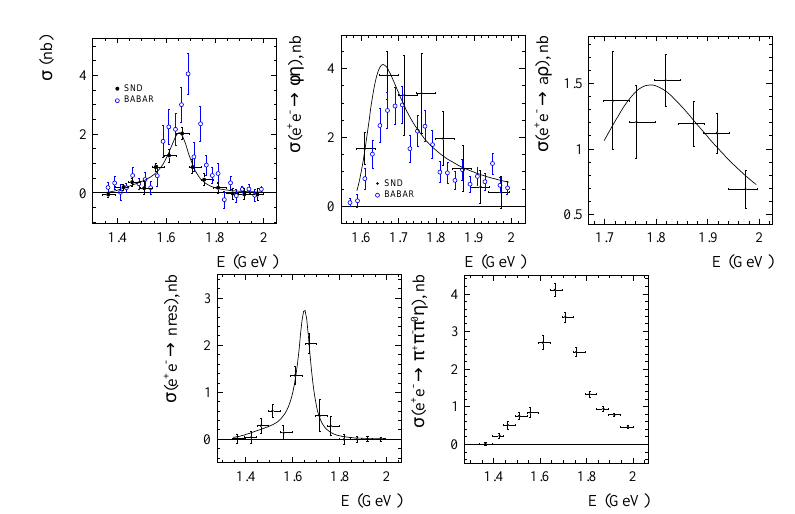
Figure 5. The cross sections measured in this work (filled circles) and in the BABAR experiment (open circles). The curve is the result of the fit described in the text. The errors of the SND data are statistical and systematic, combined in